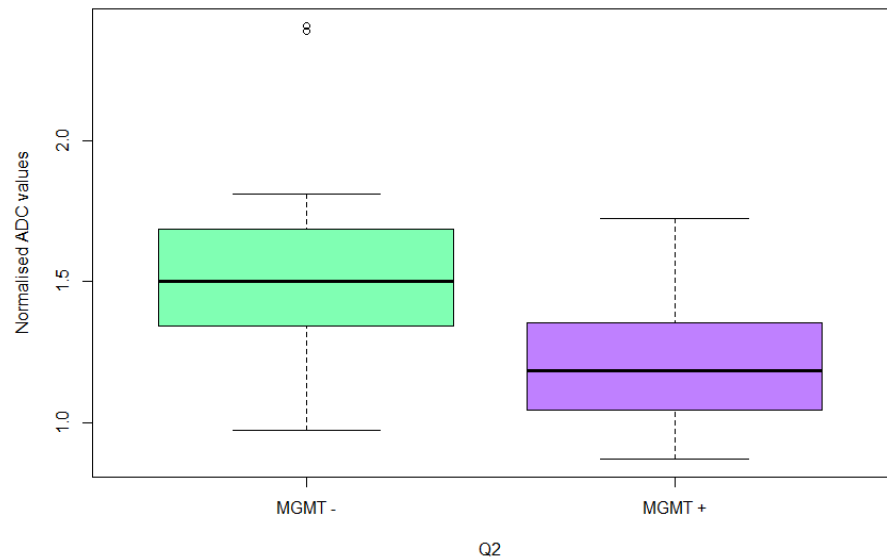
Figure 3. Normalized ADC values in peritumoral white matter (Q2) in patients with MGMT- unmethylated GB (MGMT − ) and patients with MGMT-methylated GB (MGMT +). The ROC curves were generated for the peritumoral white matter regions (T2) and normalized values of the peritumoral white matter regions (Q2) (Figure 4). The AUC for the T2-region was 0.75, and for the Q2-region 0.79.The cut-off value for the T2-region was 1.055 with the sensitivity and specificity of 0.739 and 0.737, respectively, and cut-off value for the Q2 region was 1.305 with the sensitivity of 0.783 and specificity of 0.737.